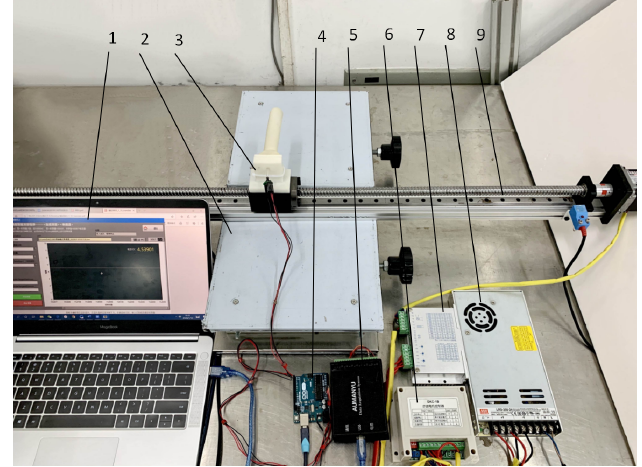
Figure 2. Diagram of experimental device: ( 1 ) master computer program, ( 2 ) lifting platform, ( 3 )